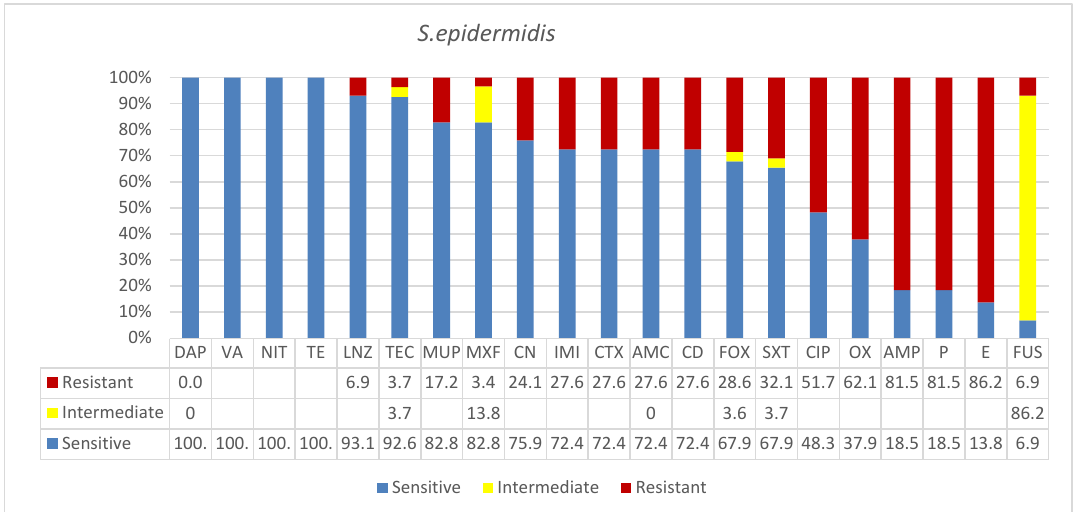
Figure 2. Antimicrobial sensitivity patterns of S. epidermidis isolates to 21 antibiotics. Abbreviations (in the order in which they appear in the figure): DAP daptomycin, VA vancomycin, NIT nitrofuran, TE tetracycline, LNZ linezolid, TEC teicoplanin, MUP mupirocin, MXF moxifloxacin, CN gentamicin, IMI imipenem, CTX cefotaxime, AMC ampicillin/sulbactam, CD clindamycin, FOX cefoxitin, SXT trimethoprim/sulfamethoxazole, CIP ciprofloxacin, OX oxacillin, AMP ampicillin, P penicillin, E erythromycin, FUS fusidic acid.